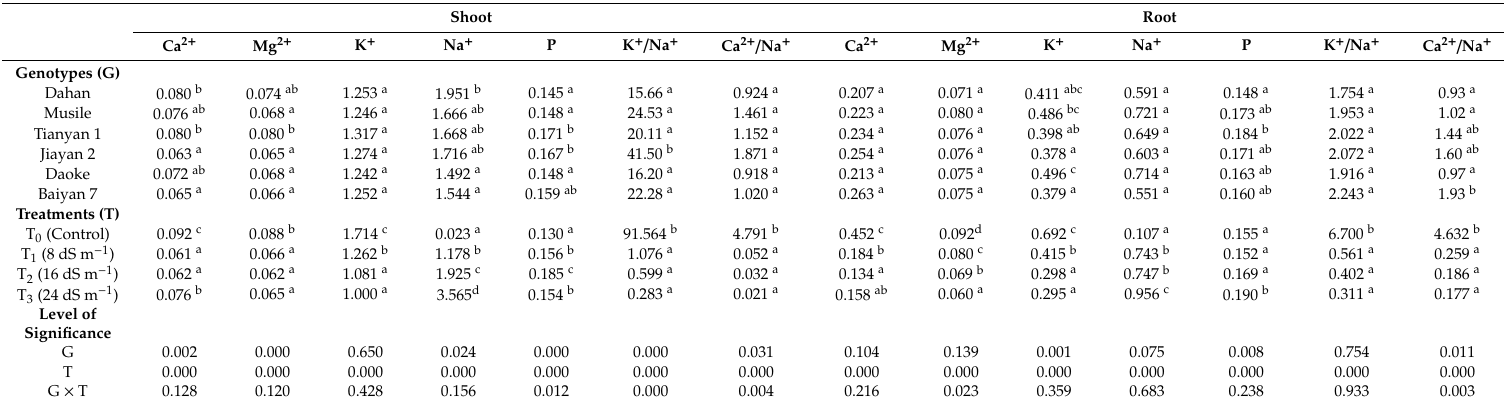
Table 5. Genotype and treatment e ff ects on ion concentration of shoots and roots of six oat genotypes grown under di ff erent combinations of salinity. Genotype values are the means of 12 measurements (four treatments and three replicates per treatment), while treatment values are the means of the 18 measurements (six genotypes and three replicates per genotype). Means followed by di ff erent letters are significantly di ff erent ( p < 0.05) according to Tukey’s-b test. The units of Ca 2 + , Mg 2 + , K + , Na + and p concentrations are mmol g − 1